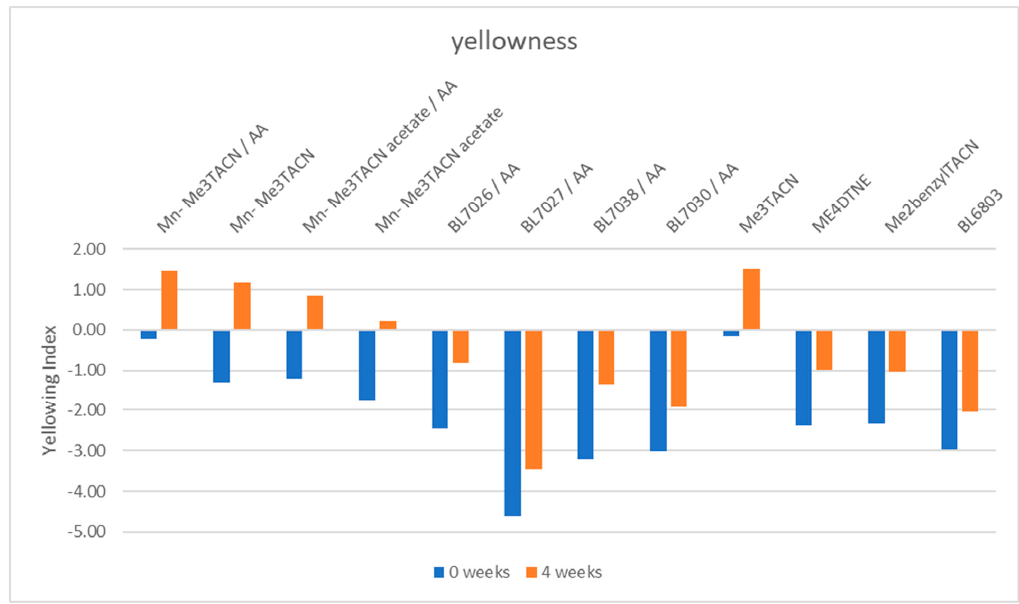
Figure 12. Yellowing Index data from selected catalysts based on Me 3 TACN analogues, before and